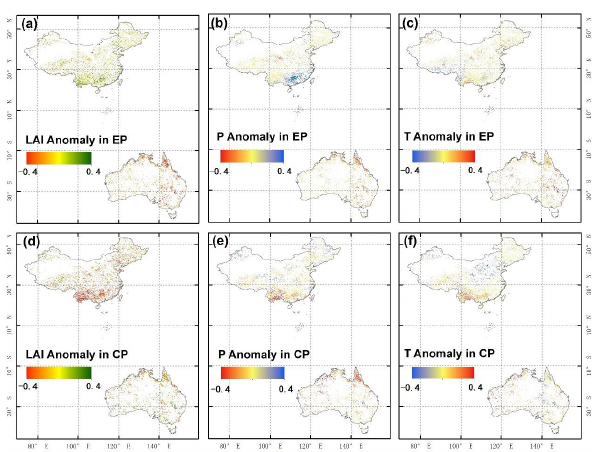
Figure 5. Multi-year average vegetation (LAI), precipitation (P), and temperature (T) anomalies during El Niño events for China and Australia. (a)-(c) Mean anomalies during EP El Niño events; (d)-(f) Mean anomalies during CP El Niño